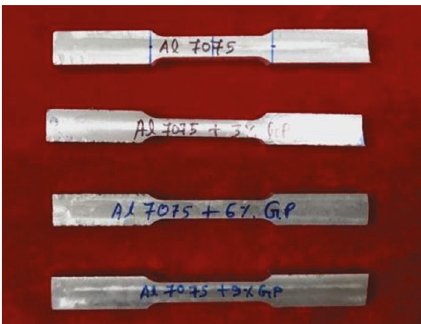
Figure 2: Tensile specimen of composites as per ASTM E08 standard.